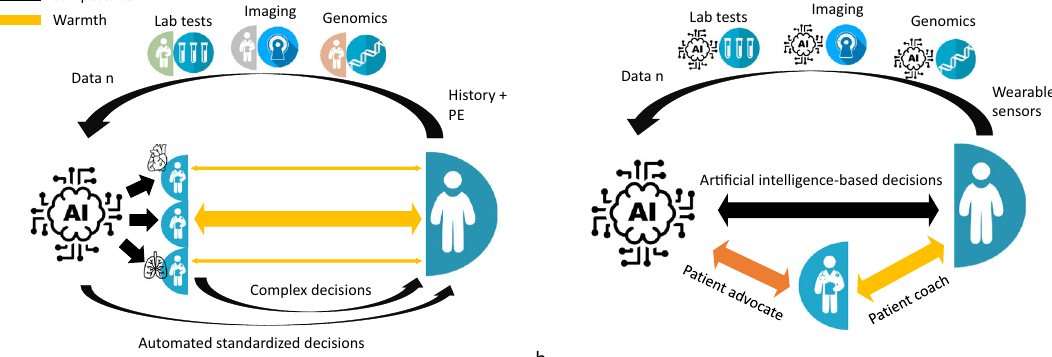
Fig. 2 Competence and warmth in the era of arti fi cial intelligence. a In the fi rst hypothetical scenario, physicians remain the conductors: they are the ones who make complex decisions involving patient values, and who prescribe the most appropriate autonomous algorithmic decision-making systems among the different available ones to delegate decisions that can be standardized or without emotional dimension. b In the second hypothetical scenario, physicians are overwhelmed by the performance of arti fi cial intelligence. They are hired by digital giants to tailor the algorithms to patients ’ values, thus becoming their advocate, and accompany the decisions made by the arti fi cial intelligence system, coaching their patient towards better health. PE physical